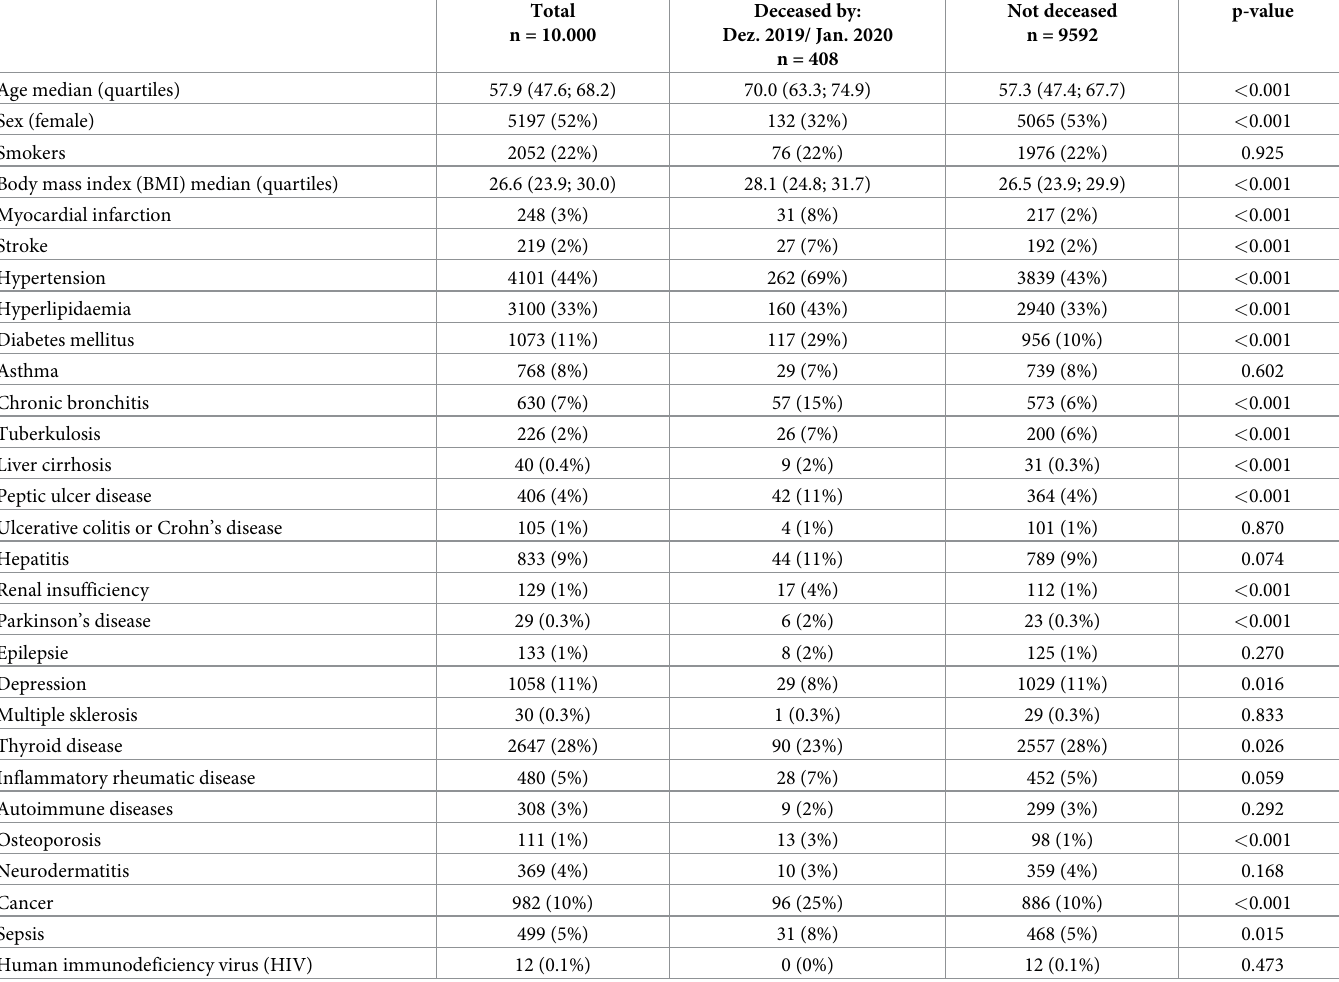
Table 1. Baseline characteristics of the 10,000 participants of the LIFE-ADULTStudy.